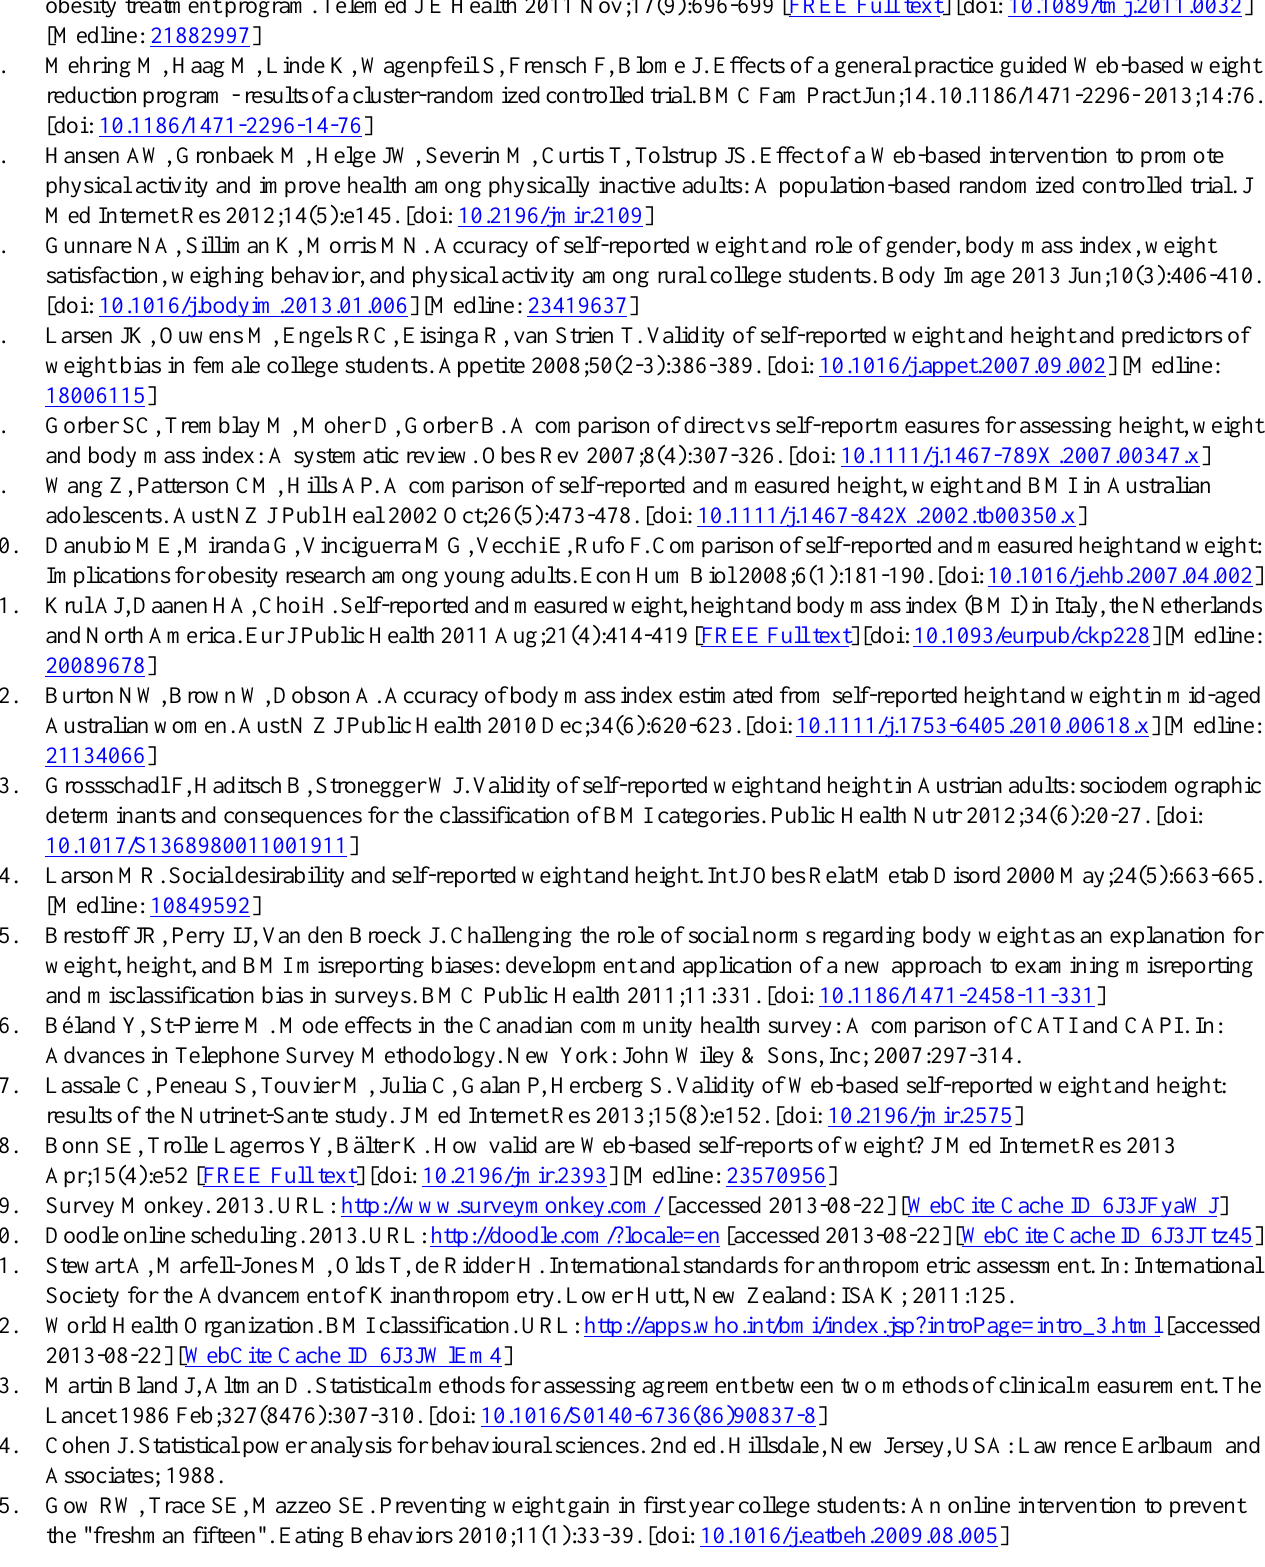
LOA: limits of agreement SEIFA: Socio-Economic Indexes for